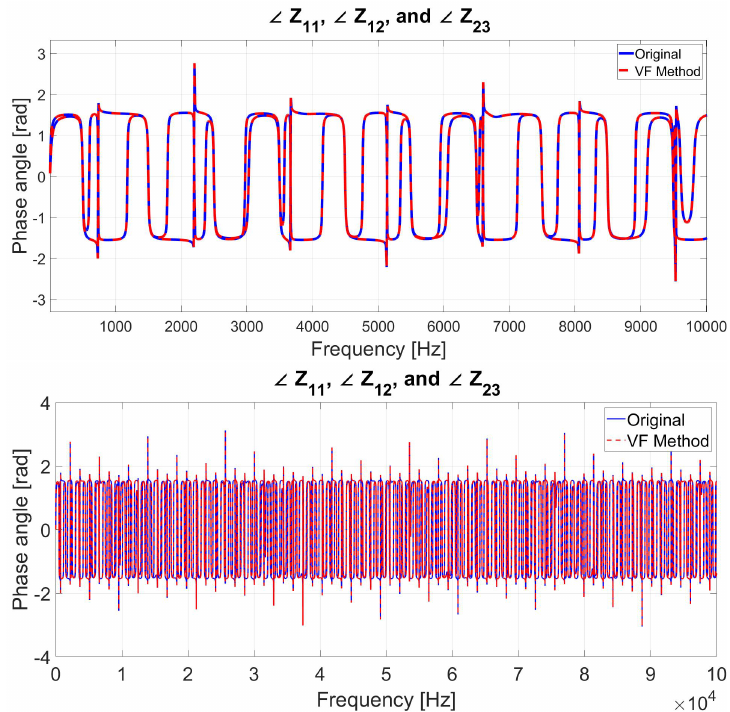
Figure 24. The angle of the measured and fitted impedance using VF , ∠ Z 11 , ∠ Z 12 , and ∠ Z 23